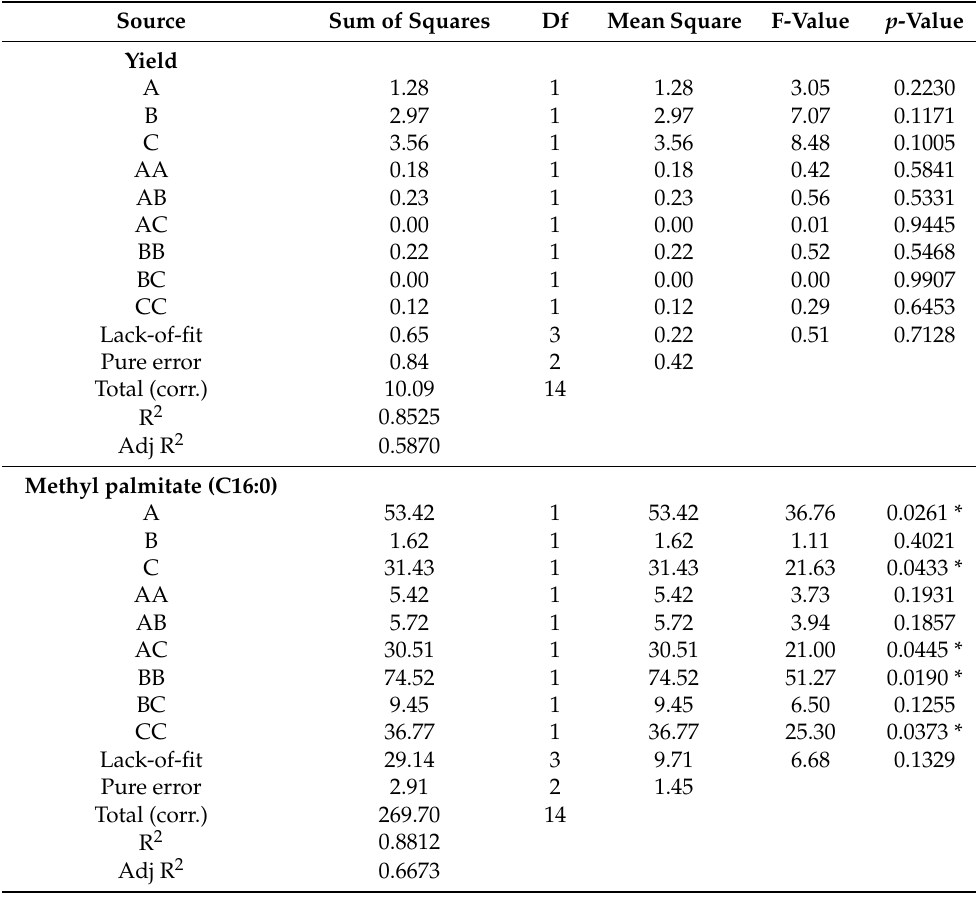
Table 2. ANOVA results for response surface quadratic models of TS extraction by